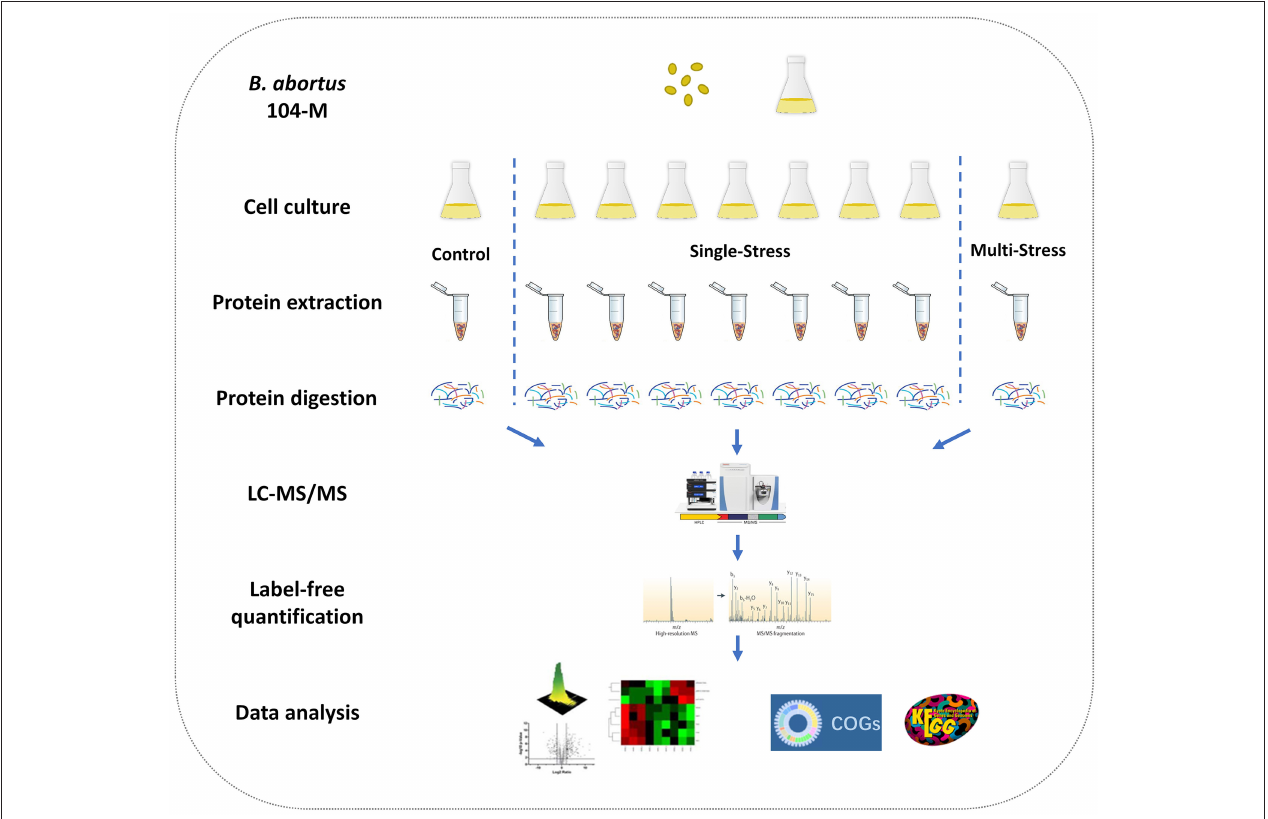
FIGURE 1 | Experimental design of the quantitative proteomics of Brucella abortus under environmental stress. A label-free relative quantitative proteomics approach was utilized to investigate and compare the global proteomic changes of B. abortus in response to a variety of distinct stresses including a control condition, seven single-stress conditions, and a multi-stress condition. Protein samples were prepared and proteolytic-digested using trypsin enzymes. Peptides were analyzed on a Q-Exactive HF MS coupled online with a nano-HPLC. The identified proteins were quantified using a label-free approach and further functionally analyzed using the COG and KEGG databases.